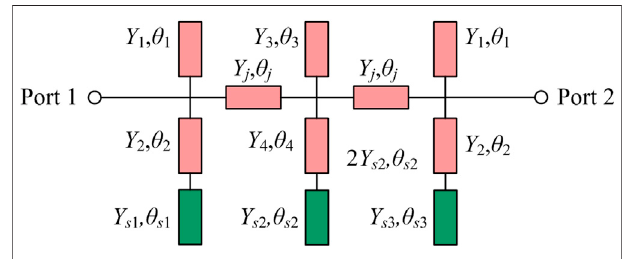
FIGURE 7 | CM equivalent circuit of the proposed balanced fi lter.